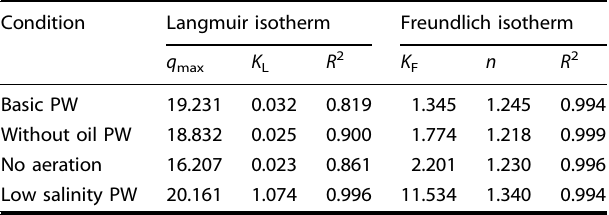
Table 3. Parameters for Langmuir and Freundlich adsorption isotherms at different conditions.